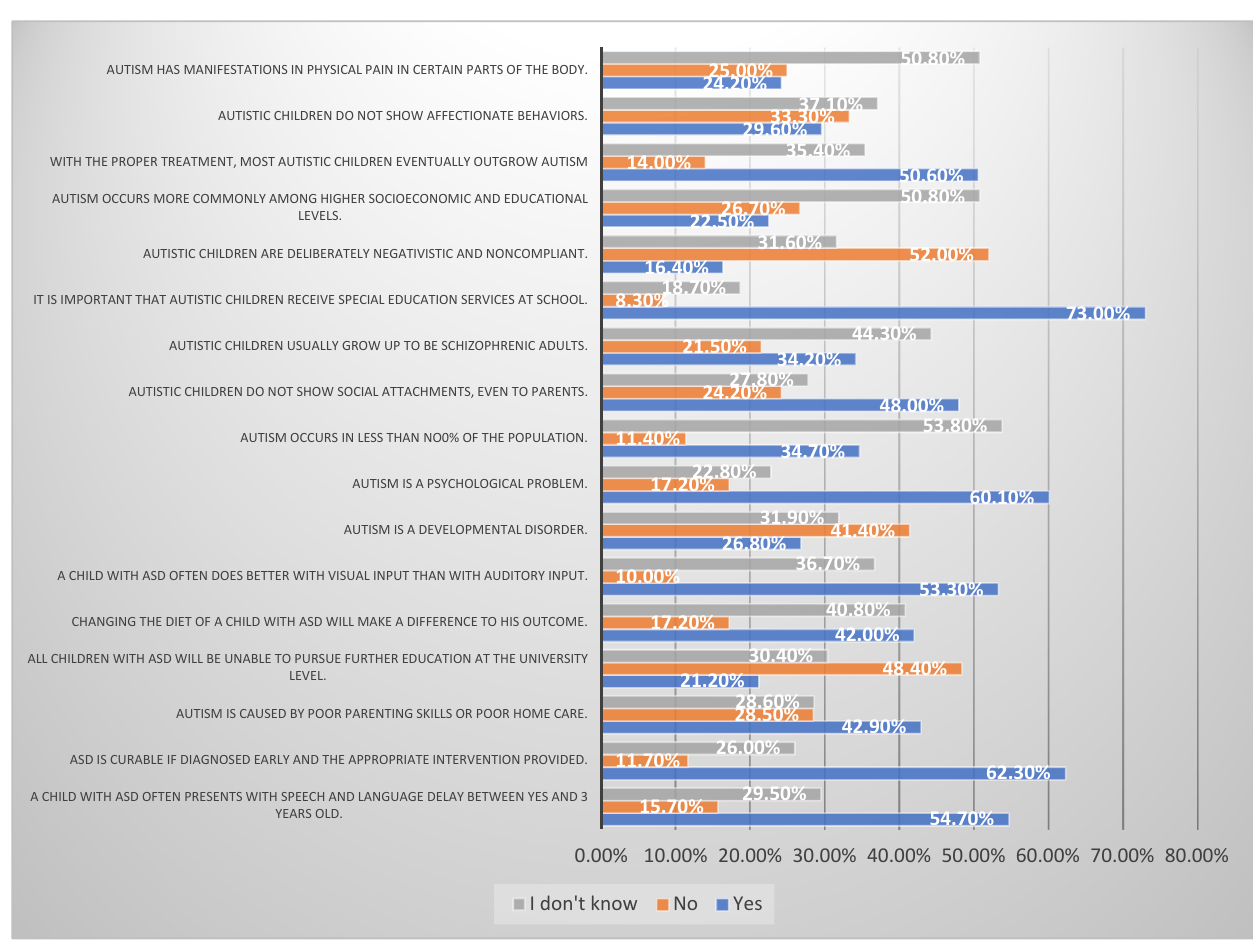
Figure 1. Participants’ responses for knowledge items.